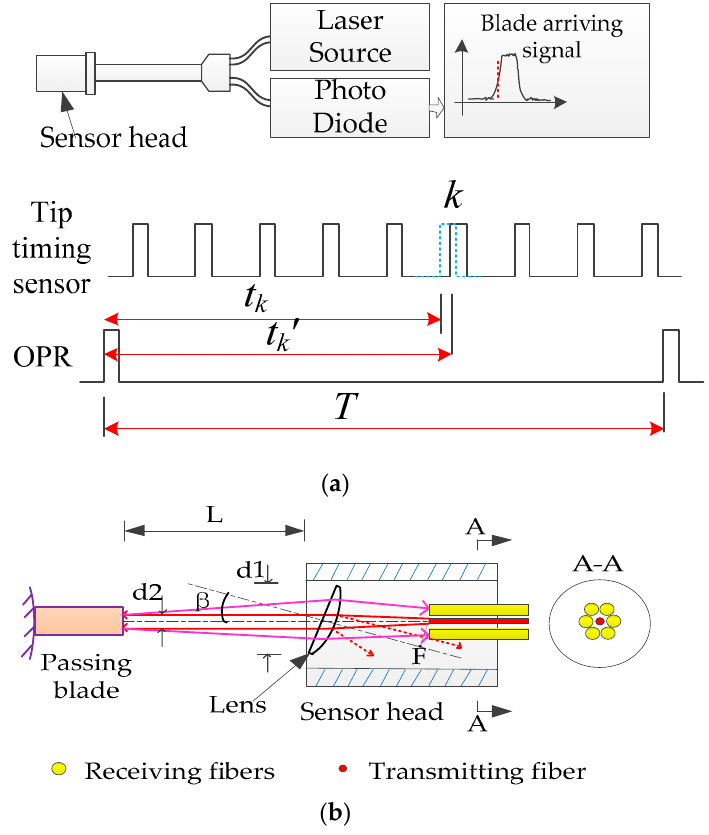
Figure 3. ( a ) The typical fiber optical tip timing sensor. ( b ) The sensor head of the fiber optical sensor with a lens.